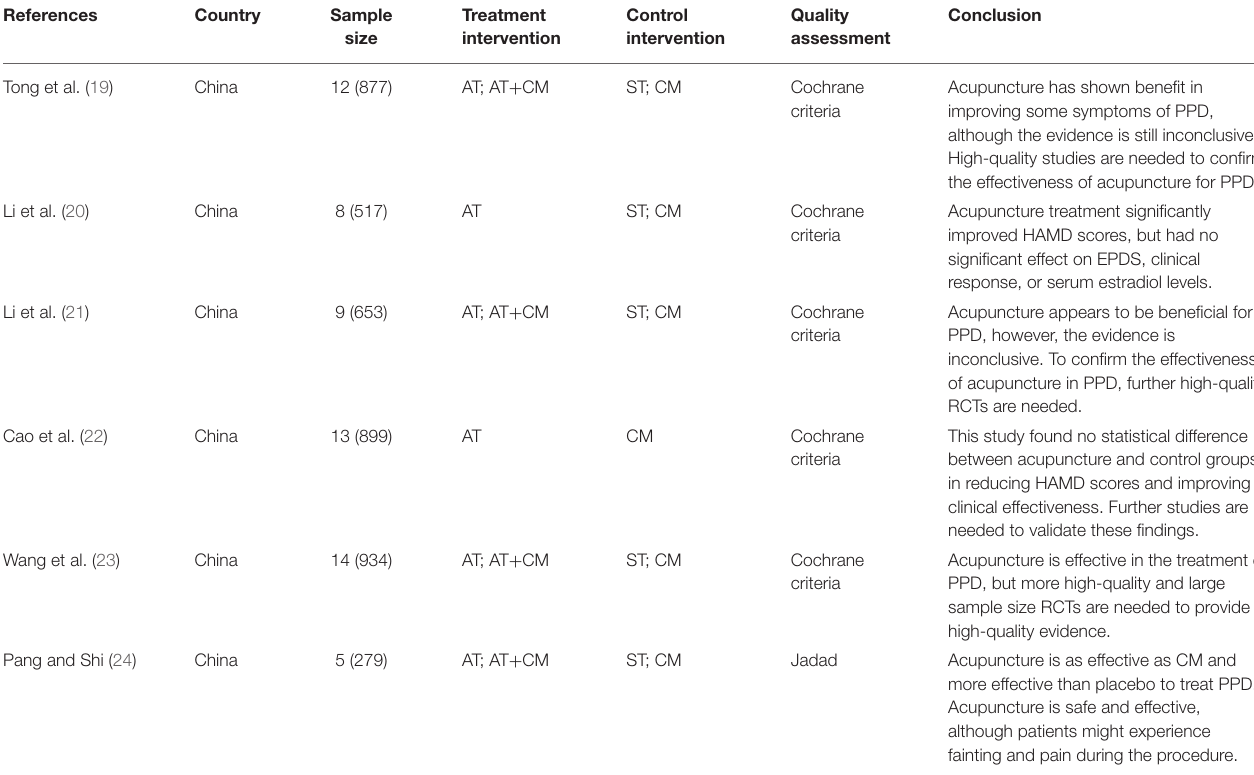
TABLE 2 | Characteristics of the included studies.